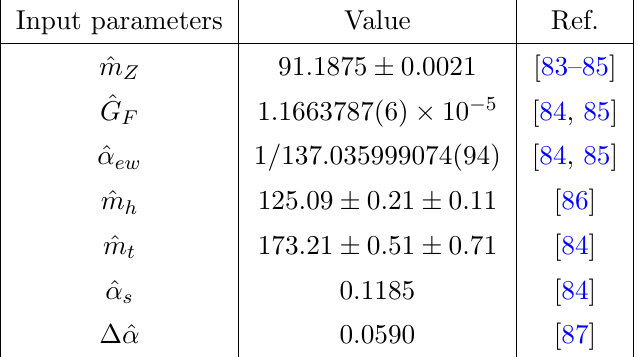
Table 1 . Input parameters values used in the global (cid:12)t in the and in